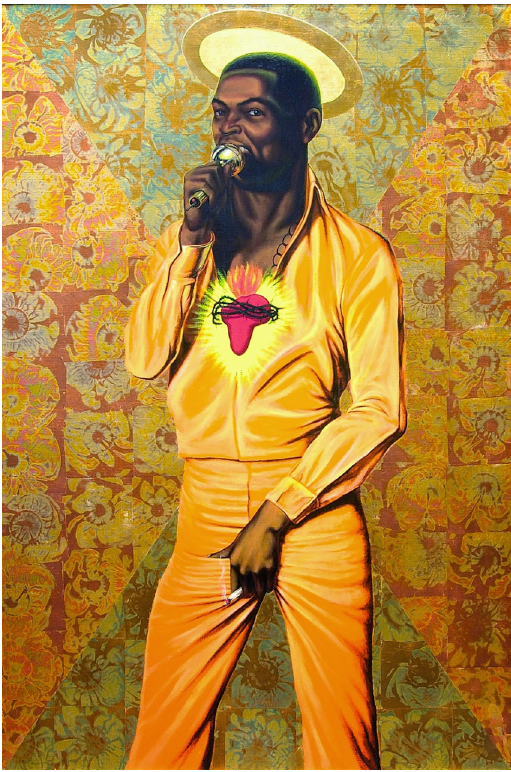
Figure 13. Hendricks, Barkley L. Fela: Amen, Amen, Amen, Amen (2002). oil and variegated leaf on linen canvas, wooden frame, altarpiece, armature, 27 pairs of high heels 66 ¾ x 46 2/4 in. ©Estate of Barkley L. Hendricks. Courtesy of Jack Shain- man Gallery, New